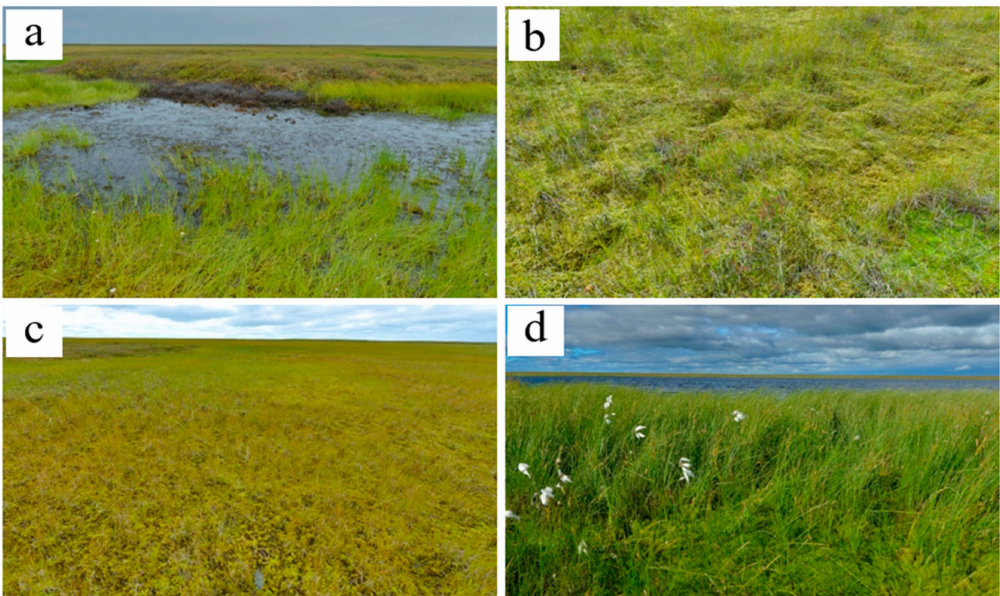
Figure 7. The vegetation of the late khasyreys: ( a )—frost mound with a dominance of ledum and lichen, and the thawed pond with Eriophorum spp.; ( b )—standing fen with Carex limosa , Carex chordorrhiza and Sphagnum obtusum ; ( c )—flowing fen with Carex chordorrhiza , Sphagnum obtusum , Calliergon stramineum and Warnstorfia exannulata ; ( d )—shore of residual pond with Carex rostrasta and Eriophorum medium